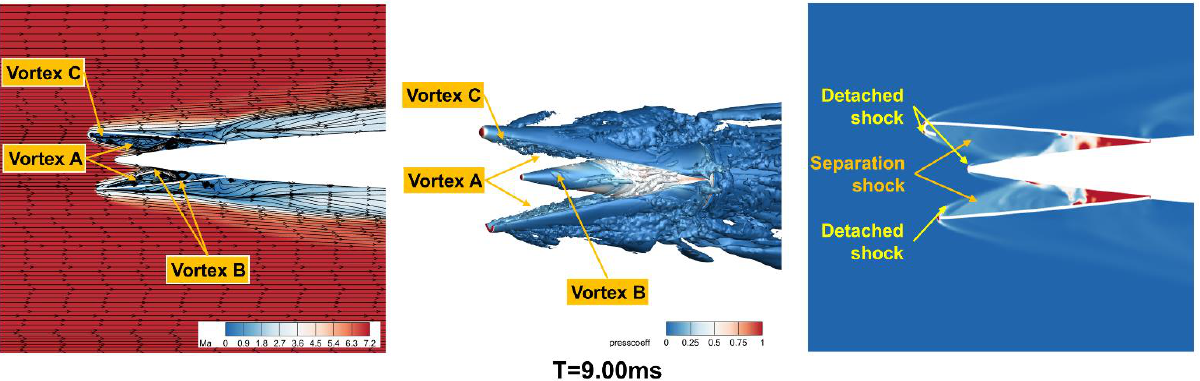
Figure 19. The contour of the streamline and Mach number ( left ), iso-surface of Q-criterion ( middle ), and the contour of the pressure coefficient ( right ) at T = 9.00 ms.